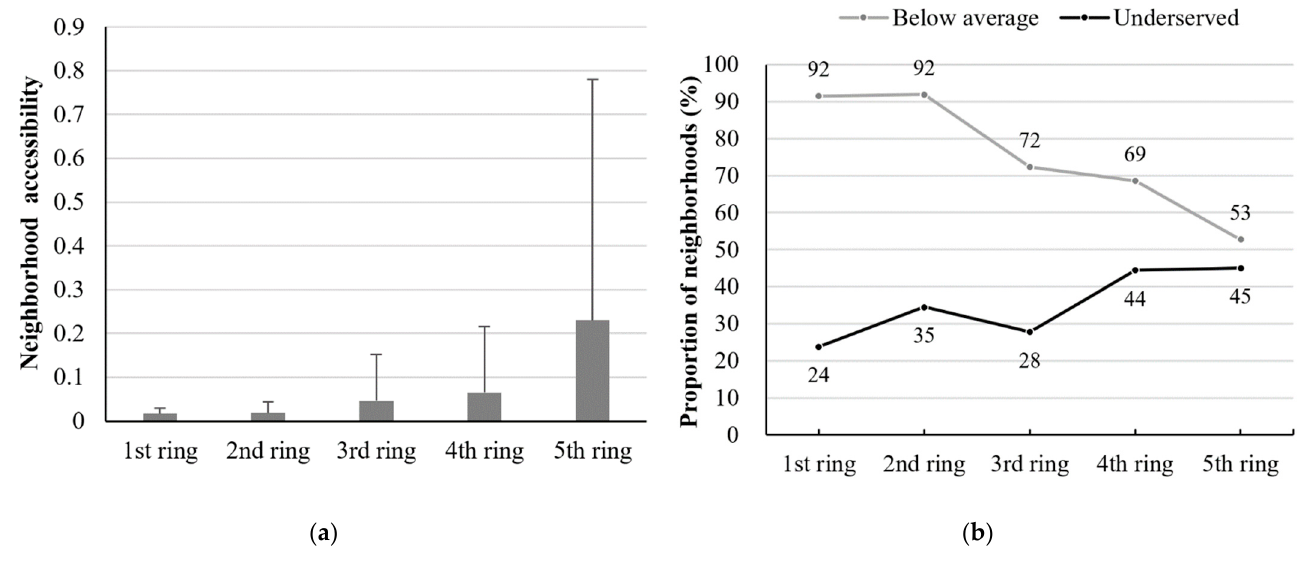
Figure 5. Statistical analysis across urban rings: ( a ) neighborhood accessibility; ( b ) proportion of below-average and underserved neighborhoods. Error bars indicate standard deviation.